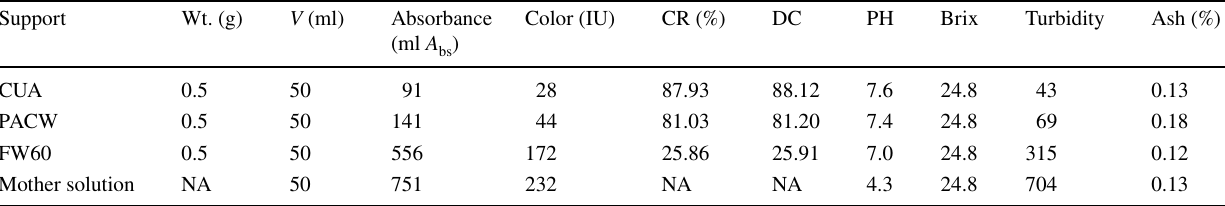
Table 2 Decolorization performance criteria of the different adsorbents for SMJ solution in terms of CR%, turbidity and ash content (0.50 g sample; 50 mL solution; 25 o